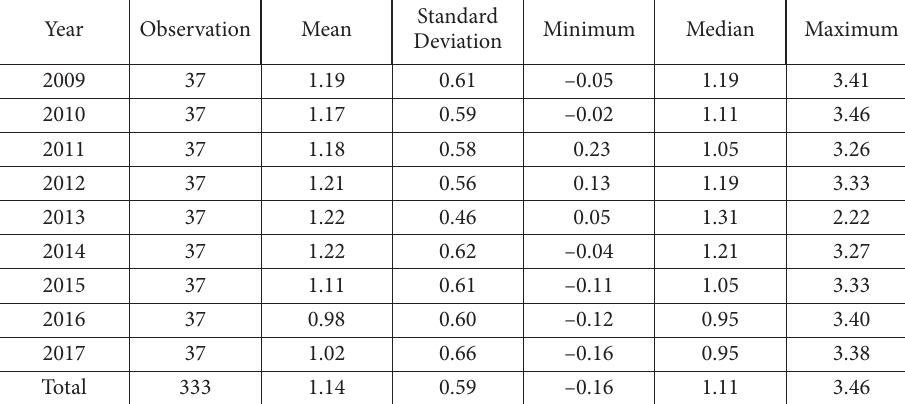
Year Observation